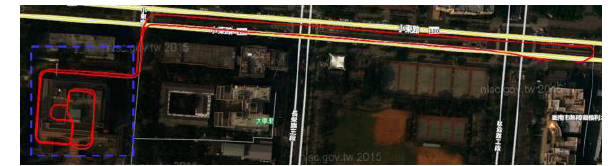
Figure 7. The configuration of mapping sensors on robot and UAV